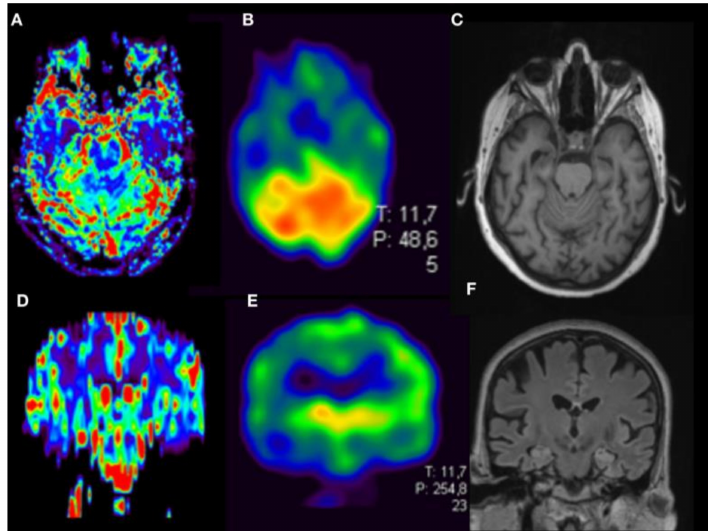
Figure 3. Female with Alzheimer’s disease, 54 y, Mini-Mental-Status-Test score 10. DSC Perfusion ( A , axial orientation; D , coronal orientation rCBVc map) shows typical pattern of frontotemporal and parietal cortical hypoperfusion. Correlation with HMPAO-SPECT. ( B , E ) and anatomical datasets with widening of the temporal horns and apico-frontal cisterns as signs of atrophy (T1w in C , T2 SPACE in F